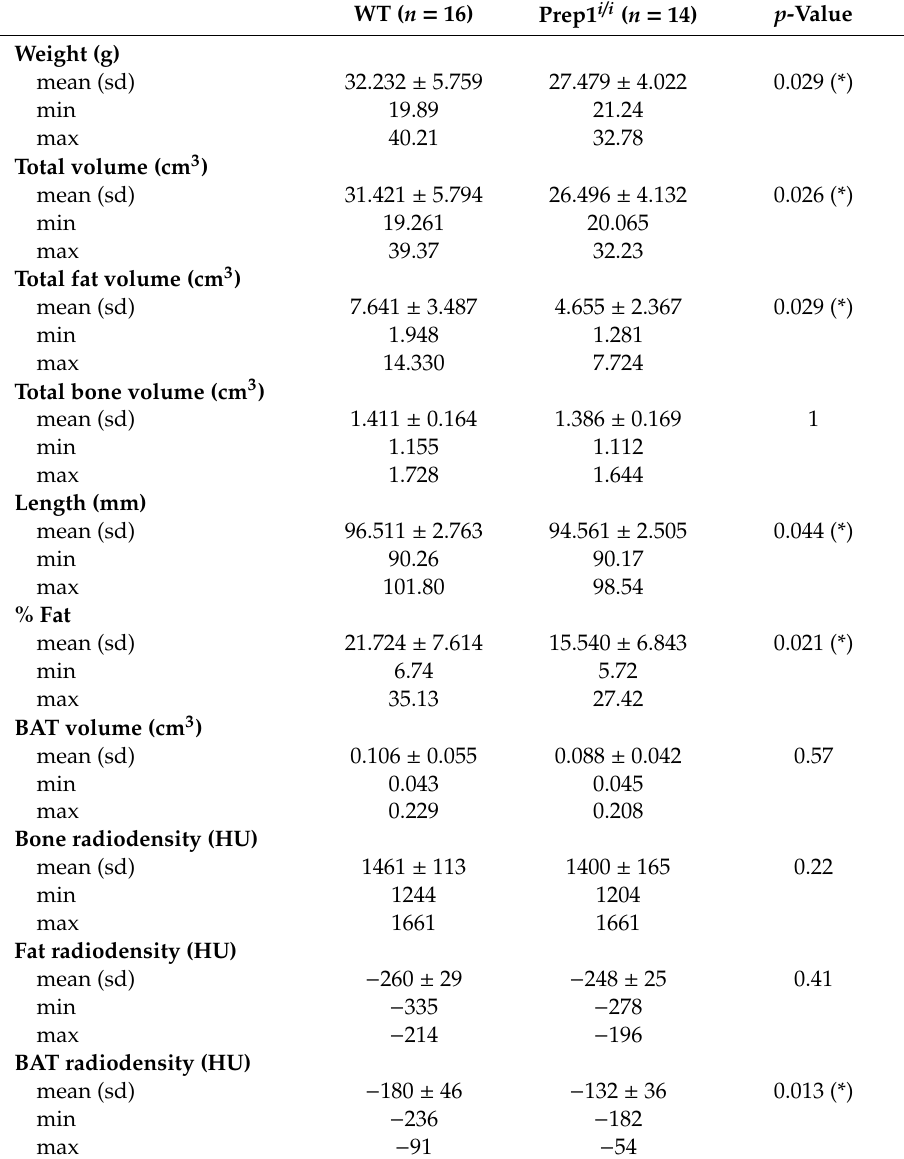
Table 1. Summary of the in vivo morphometric analysis. Comparison between the two groups for each variable are performed by Mann-Whitney non-parametric test. An asterisk (*) after the p -value denotes a significant di ff erence between